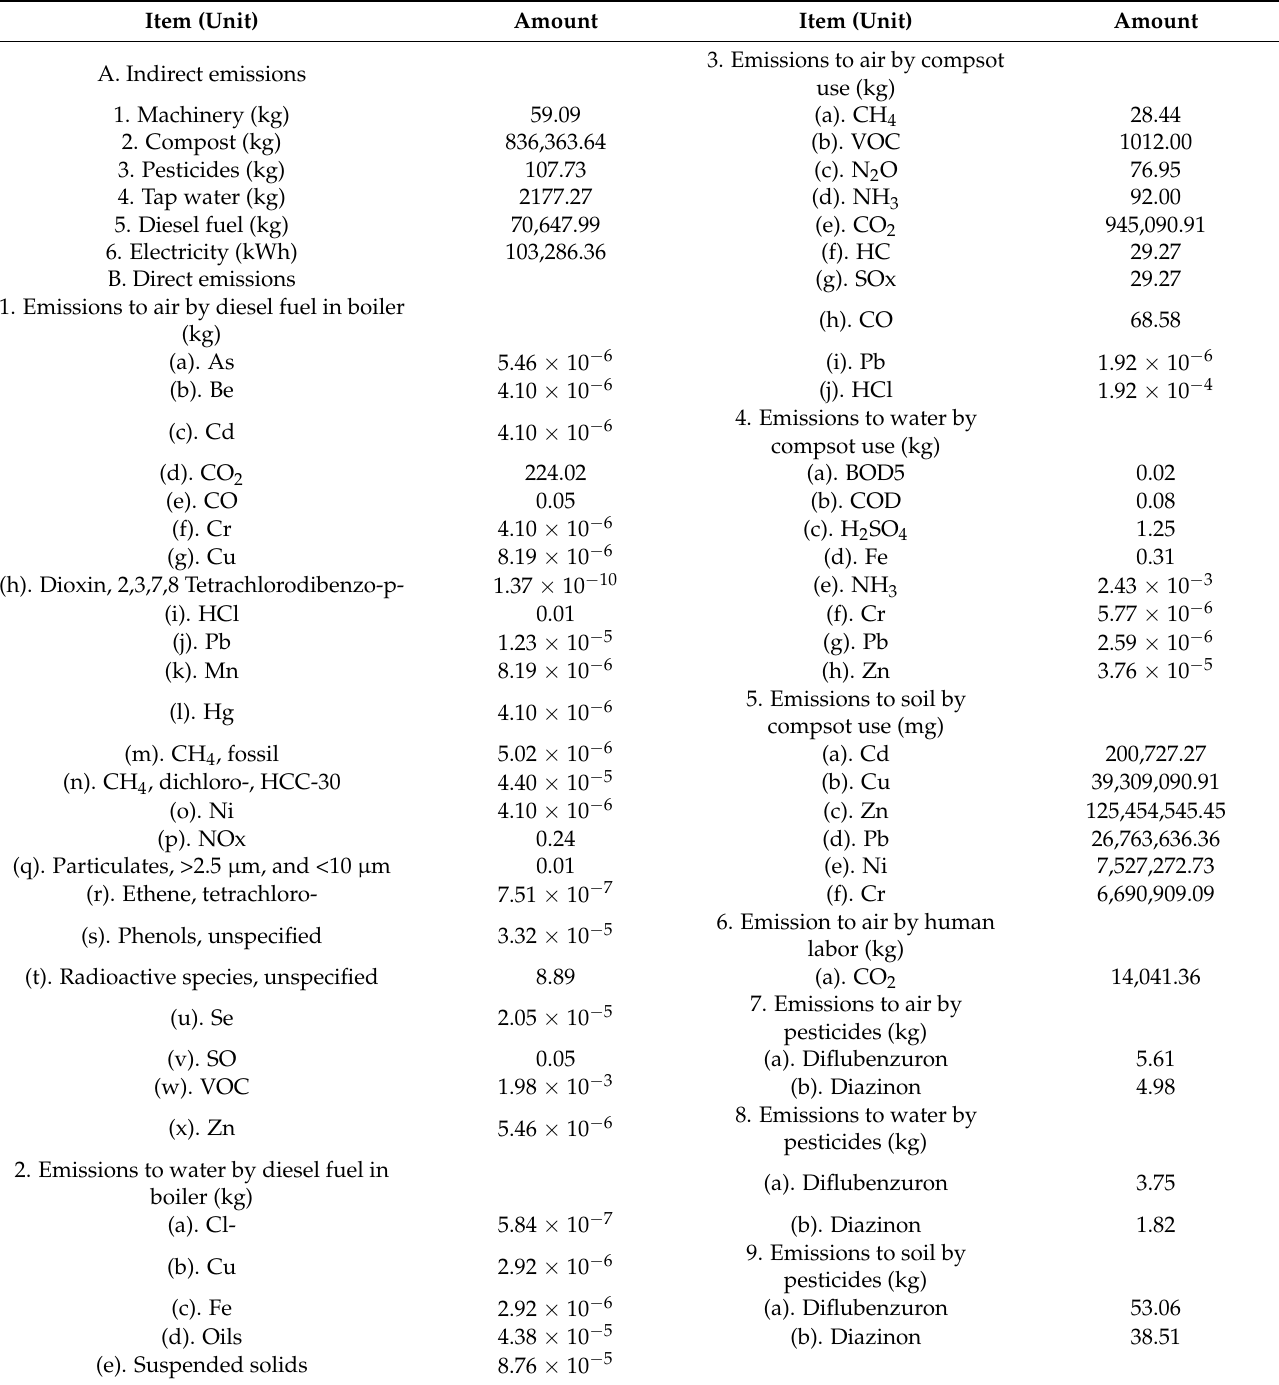
Table 3. LCI of mushroom production in Isfahan province per